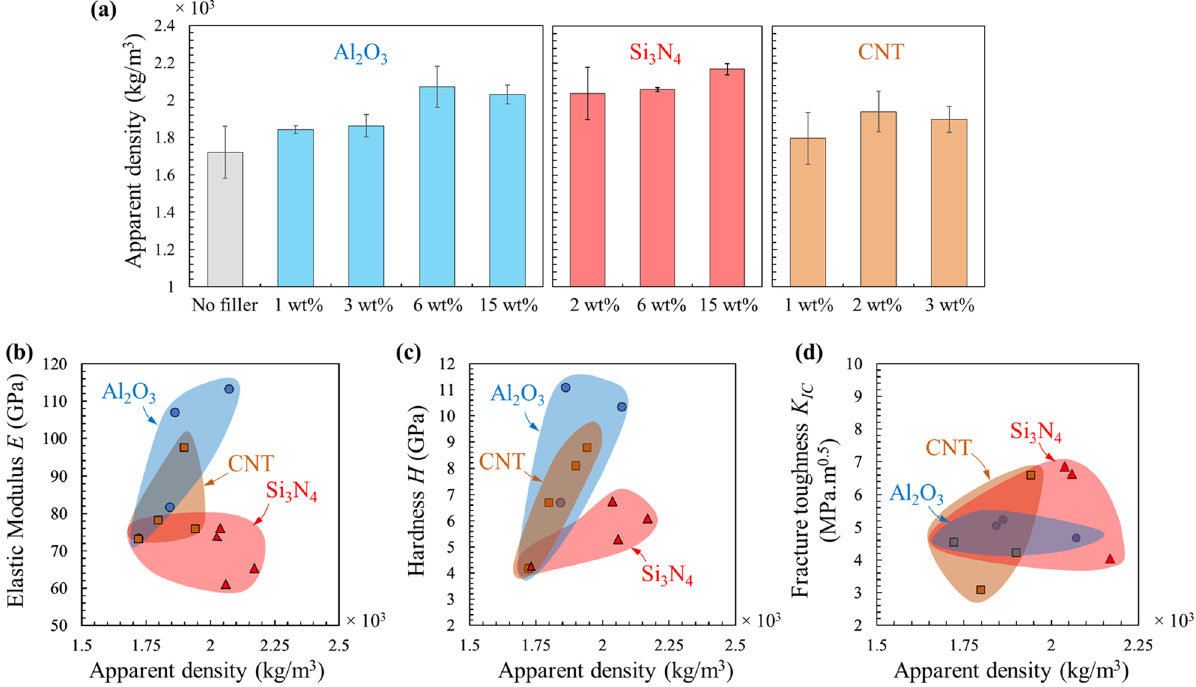
Figure 4. Density–property maps for PDCs modified with nano-particles or CNTs. ( a ) The densities of PDCs made with different concentrations of alumina nanoparticles, silicon nitride nanoparticles, and CNTs. ( b–d ) The correlation between ( b ) modulus, ( c ) hardness, and ( d ) fracture toughness of PDCs and their apparent density.